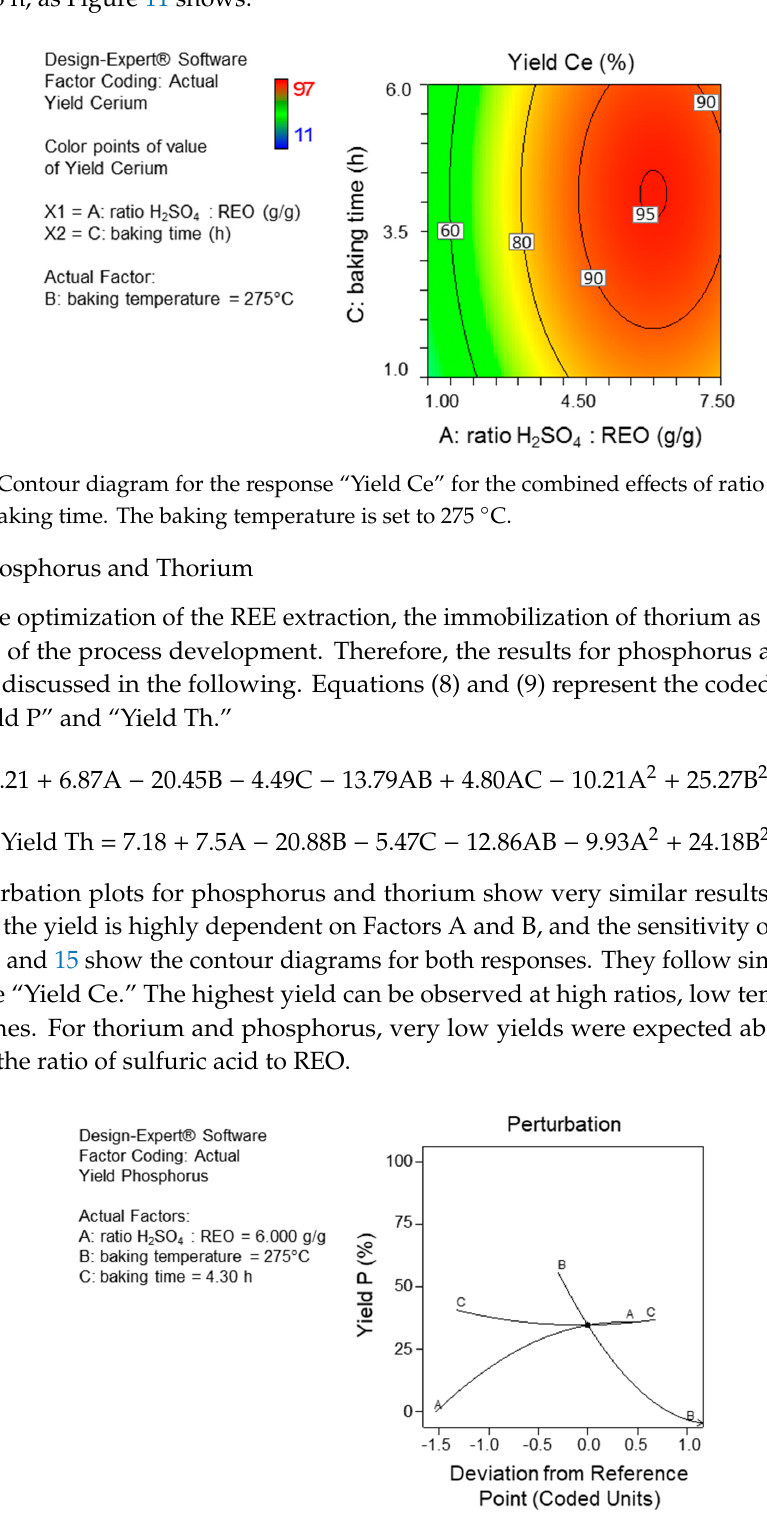
Figure 12. Perturbation plot for the response “Yield P.”